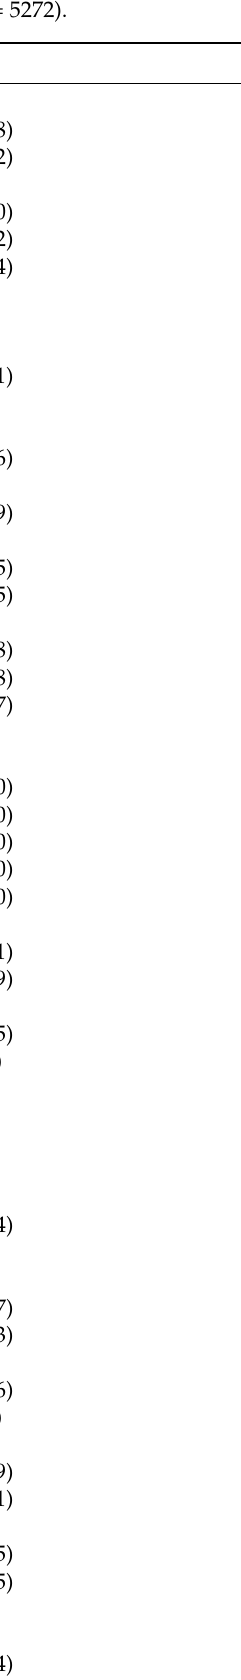
Table 2. Descriptive analysis of all individual variables in Wave 9 ( n =